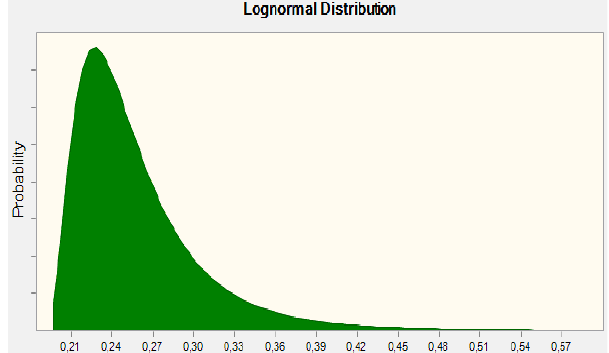
Figure 4. Probability distribution of accommodation facilities’ occupancy in the region of Poprad– Vysoké Tatry during 2003–2019. Table 4. Descriptive statistics of probability distribution for accommodation facilities’ occupancy in the region of Poprad–Vysok é